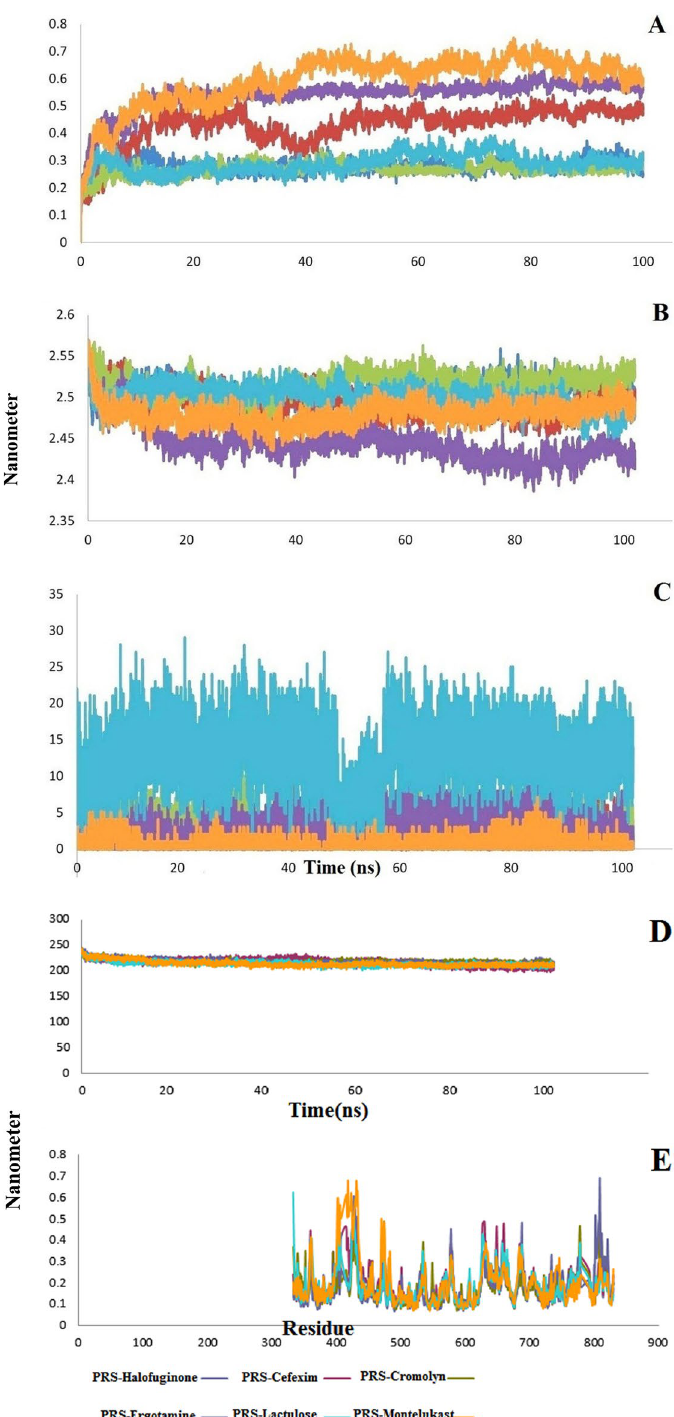
Figure 5. ( A ) RMSD values of PRS docked complexes. ( B ) Rg values of PRS docked complexes. ( C ) Number of H-bonds of PRS docked complexes. ( D ) SASA values of PRS docked complexes. ( E ) The RMSF values of PRS protein in the simulated complexes compared to PRS-Halofuginone complex as a